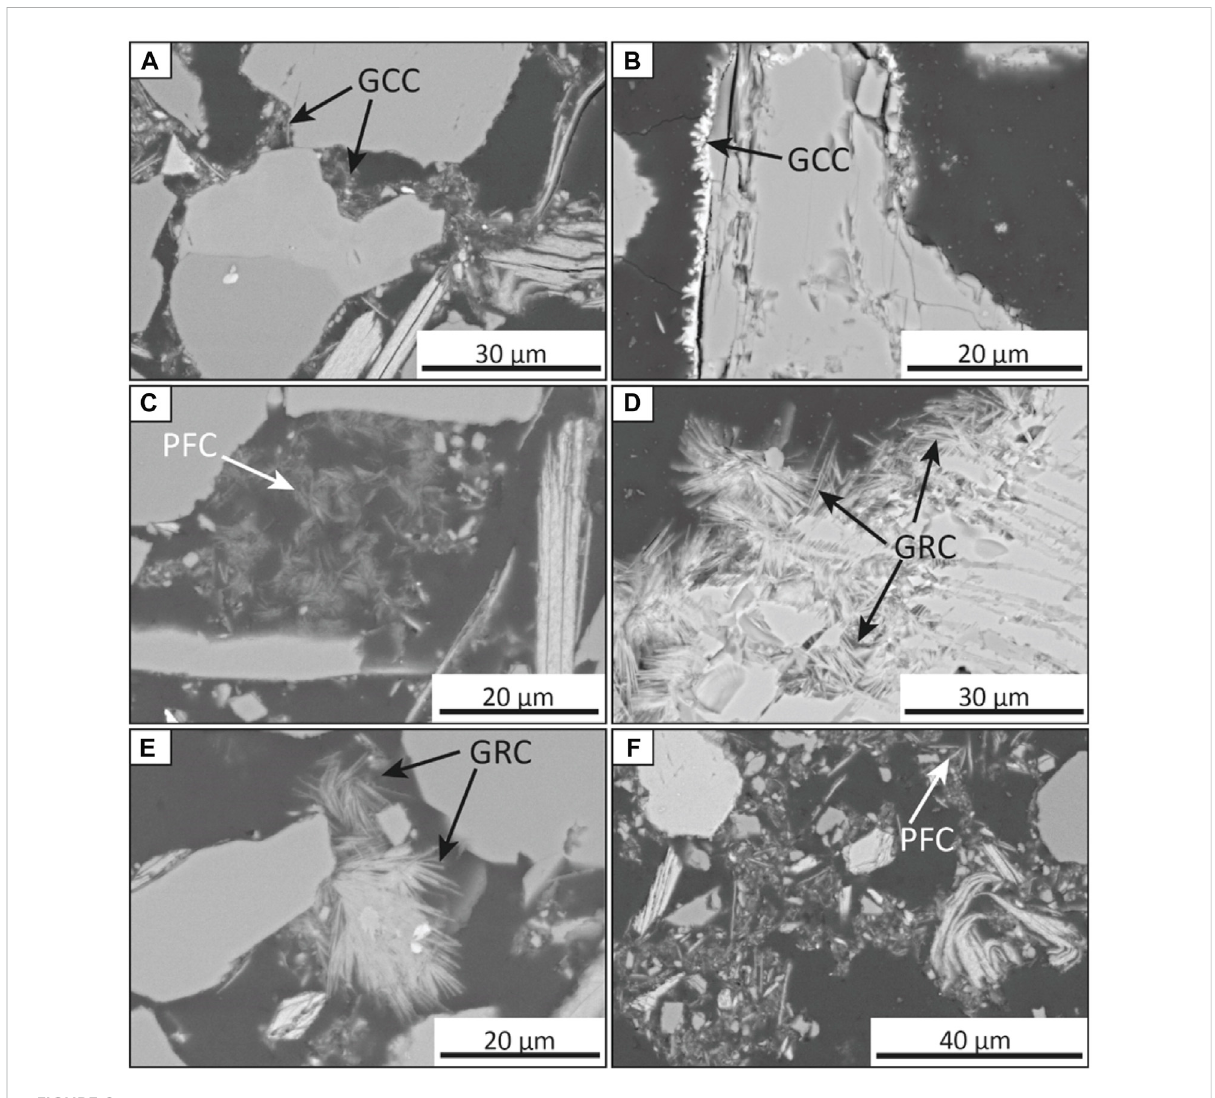
FIGURE 8 BSEimagesshowingexamplesofgrain-coating,pore- fi lling,andgrain-replacingchloriteinthereactedsamplesoftheButeInlet. (A) BSEimage of authigenic grain-coating chlorite (GCC), growing parallel to quartz grain surface and from a precursor chlorite coat, (Sample 6). (B) BSE image of neoformed grain-coating chlorite (GCC) growing perpendicular to a detrital albite grain surface (Sample 6). (C) BSE image showing pore- fi lling chlorite(PFC)destroyingintergranularporosity(Sample5). (D) BSEimageofgrain-replacivechlorite(GRC),replacingpartlydissolvedK-feldspar (Sample 3). (E) BSE image showing a fan-like, grain-replacive chlorite (GRC), replacing detrital biotite (Sample 5). (F) BSE image showing pore- fi lling chlorite (PFC) growing from or replacing precursor pore- fi lling chlorite, probably Mg-rich chlorite (Sample 6). (BSE, Backscattered